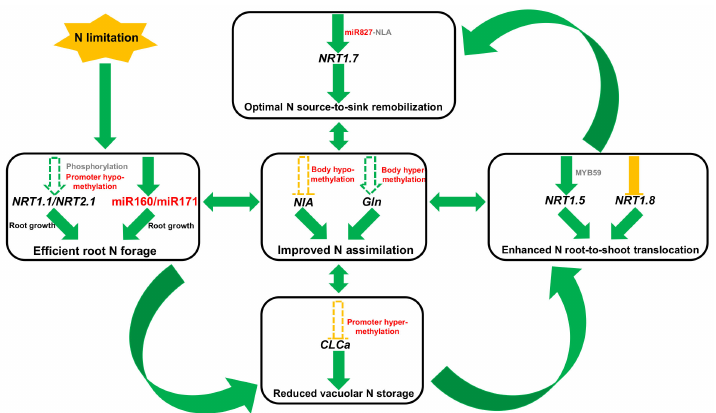
Figure 10. A proposed model showing the strategy of rapeseed plants to enhance N-limitation-triggered adaptation and use e ffi ciency. Under N limitation, the phosphorylation and promoter hypomethylation resulted in the elevated expression of NRT1.1 and NRT2.1 , and the increased expression of miR160 and miR171, all of which contributed to stronger root system that facilitated e ffi cient N forage. Limited N supply repressed the expression of CLCa through promoter hypermethylation regulation, and it reduced vacuolar N storage, which was favorable for N assimilation in the cytoplasm. In addition, N limitation also enhanced the NRT1.5 expression and repressed the NRT1.8 expression, both of which facilitated N translocation from roots to shoots. Furthermore, in the shoots, limitation of N induced an increase in the miR827 expression that downregulated the E3 ubiquitin ligase NLA, which accelerated the remobilization of N nutrients from old leaves to young ones through modulating NRT1.7 degradation. The hypomethylation of the nitrate reductase NIA1 and hypermethylation of Gln1;1 within their gene bodies might be responsible for the reduced expression of NIA1 and increased expression of Gln1;1 . Green solid arrows and yellow solid lines indicate the valid processes or genes are induced and repressed by N limitation, and the dashed arrows indicate potential DNA methylation under N limitation. Red words indicate the epigenetic regulation of N-metabolism genes identified in this study, and grey words refer to regulatory mechanisms that were previously